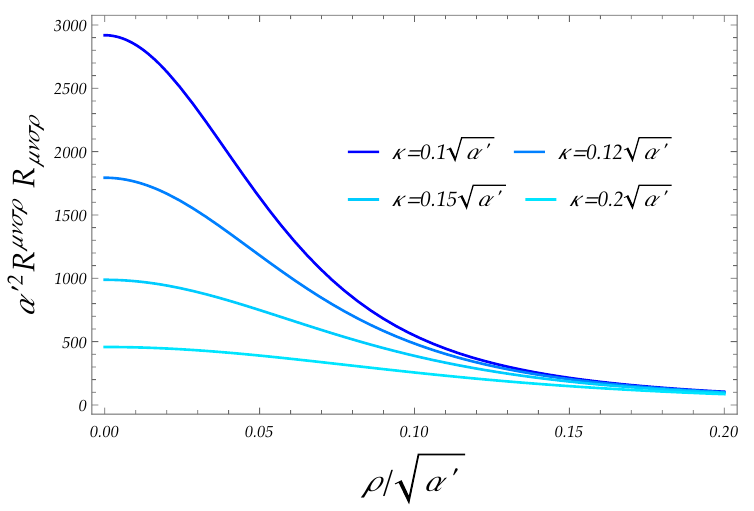
Figure 4 . Value of the Kretschmann invariant for the global instanton solution for di(cid:11)erent values of (cid:20) 2